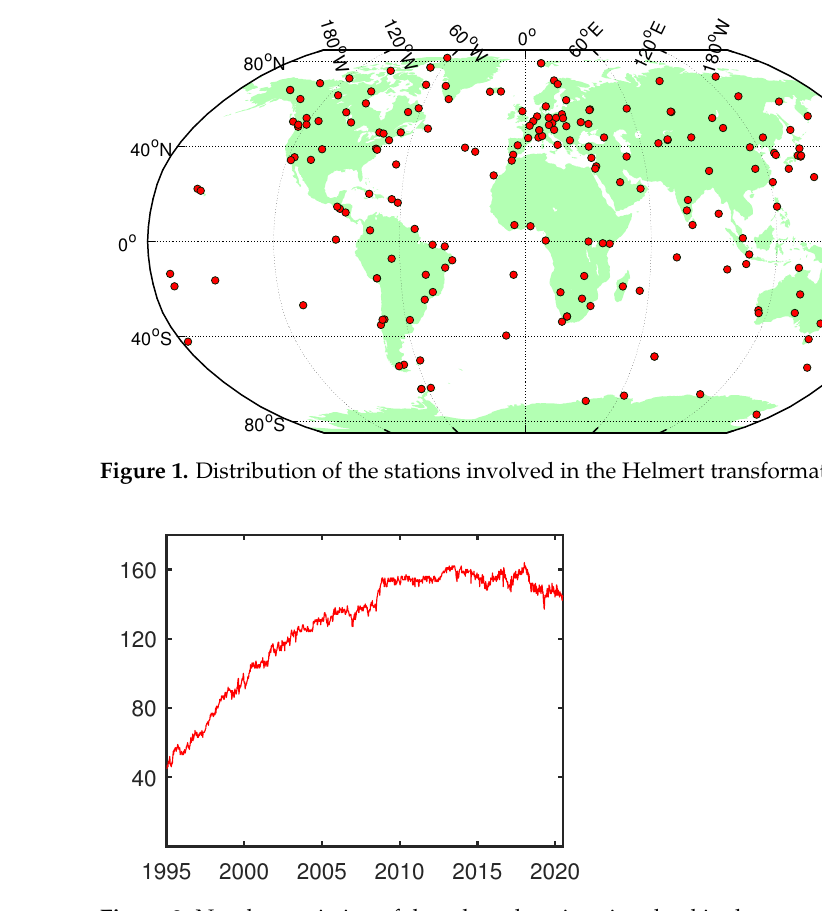
Figure 2. Number variation of the selected stations involved in the